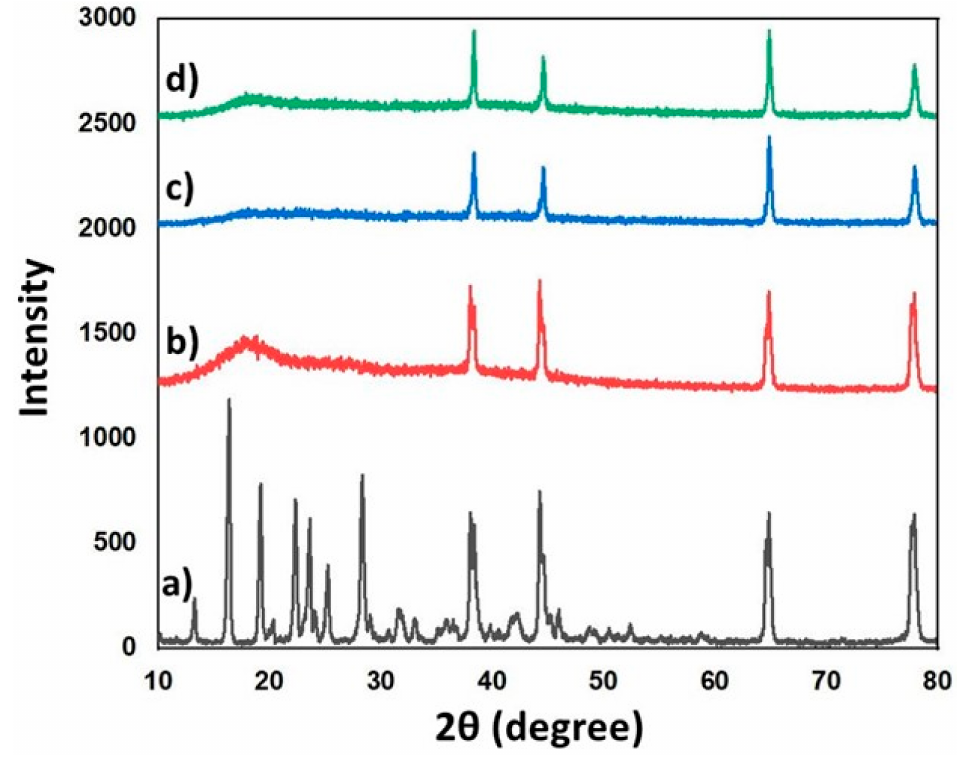
Figure 4. XRD spectra of ( a ) RS, ( b ) hHL, ( c ) hHL/0.05RS, ( d ) hHL/0.1RS